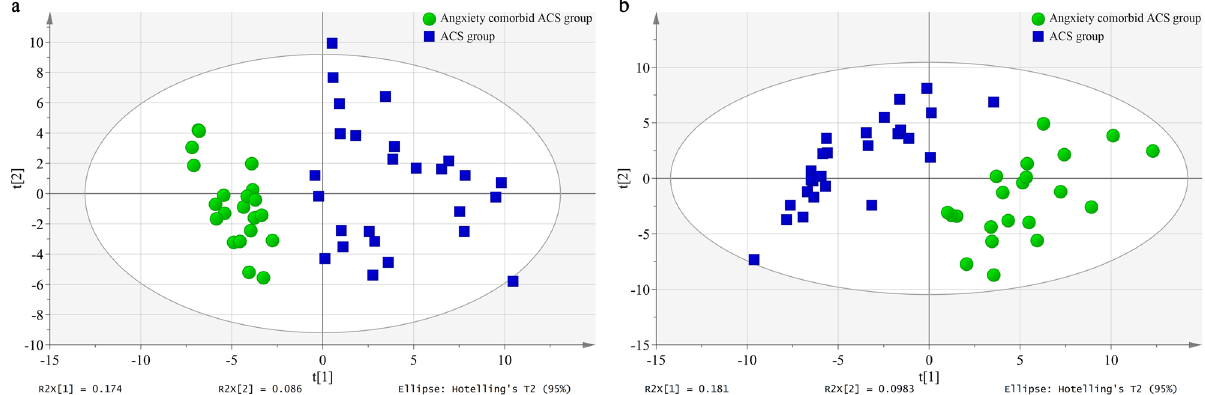
Figure 4. PCA score plots derived from LC–MS analysis of plasma from anxiety comorbidity ACS and ACS group in different ion modes. Plasma in positive ion mode ( a ), in negative ion mode ( b ).